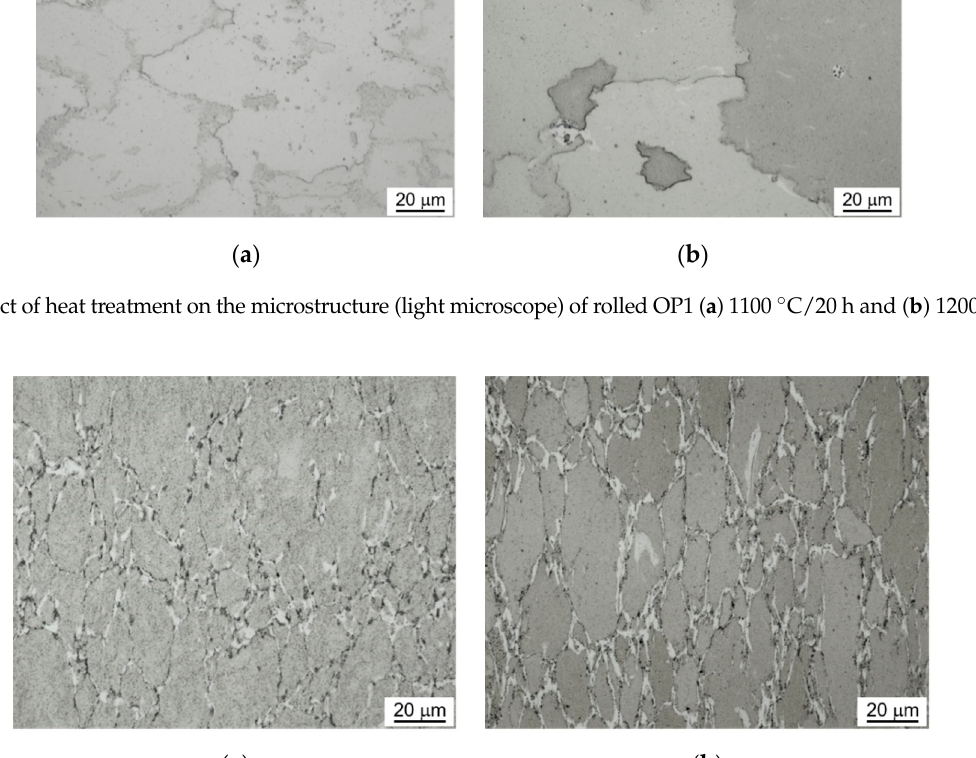
Figure 5. Effect of heat treatment on the microstructure (light microscope) of forged OP1 ( a ) 1100 °C/20 h and ( b ) 1200 °C/20 h.